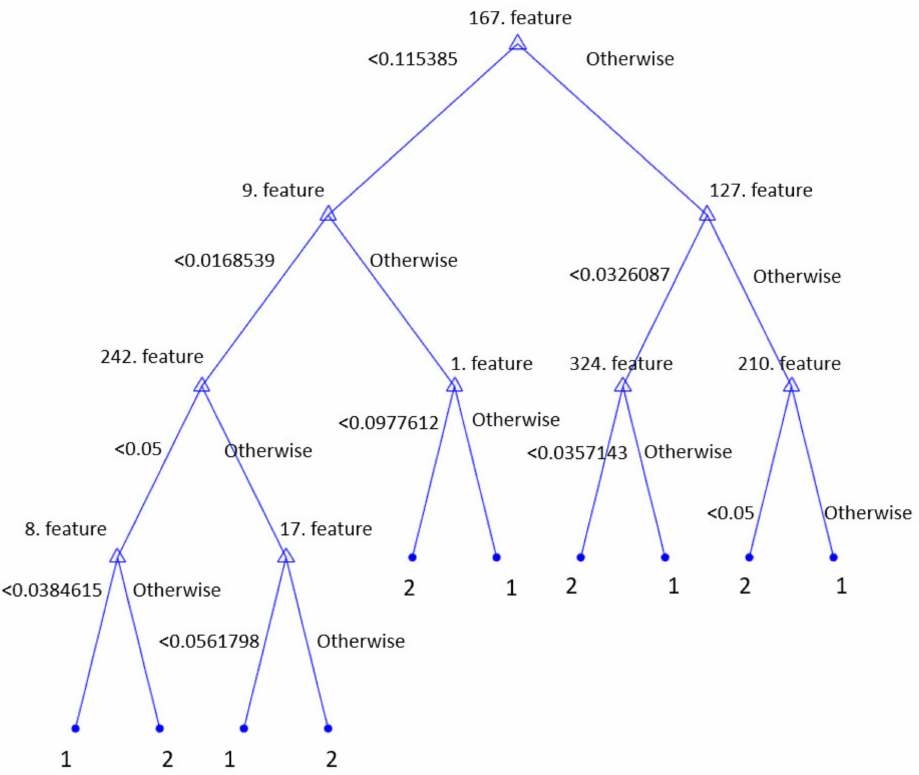
Figure 6. Rules of a basic decision-support system using our selected features. Herein, the symbol 1 denotes COVID-19, while 2 denotes